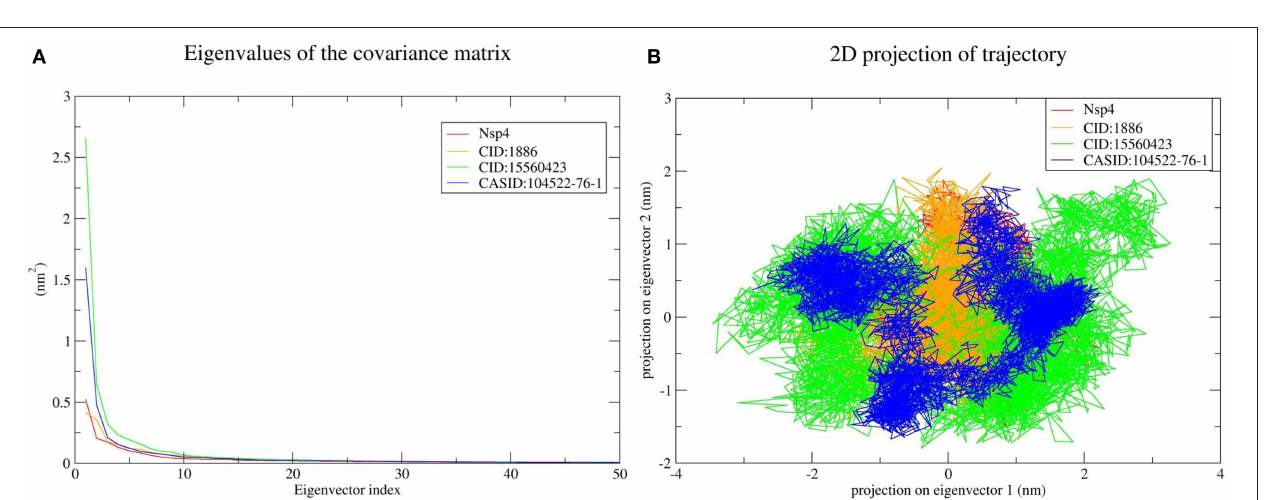
FIGURE 6 | Principal component analysis of CD163-SRCR5 and the CD163-SRCR5-phytochemical complexes. (A) Plots of eigenvalues vs. the first 50 eigenvectors derived from the final 25 ns of MD simulations. (B) The first two eigenvectors representing the motion of CD163-SRCR5 and its complexes in phase space. Maroon, orange, green, and blue colors represent CD163-SRCR5, CD163-SRCR5-CID:1886, CD163-SRCR5-CID:15560423, and CD163-SRCR5–CASID:104522-76-1, respectively.